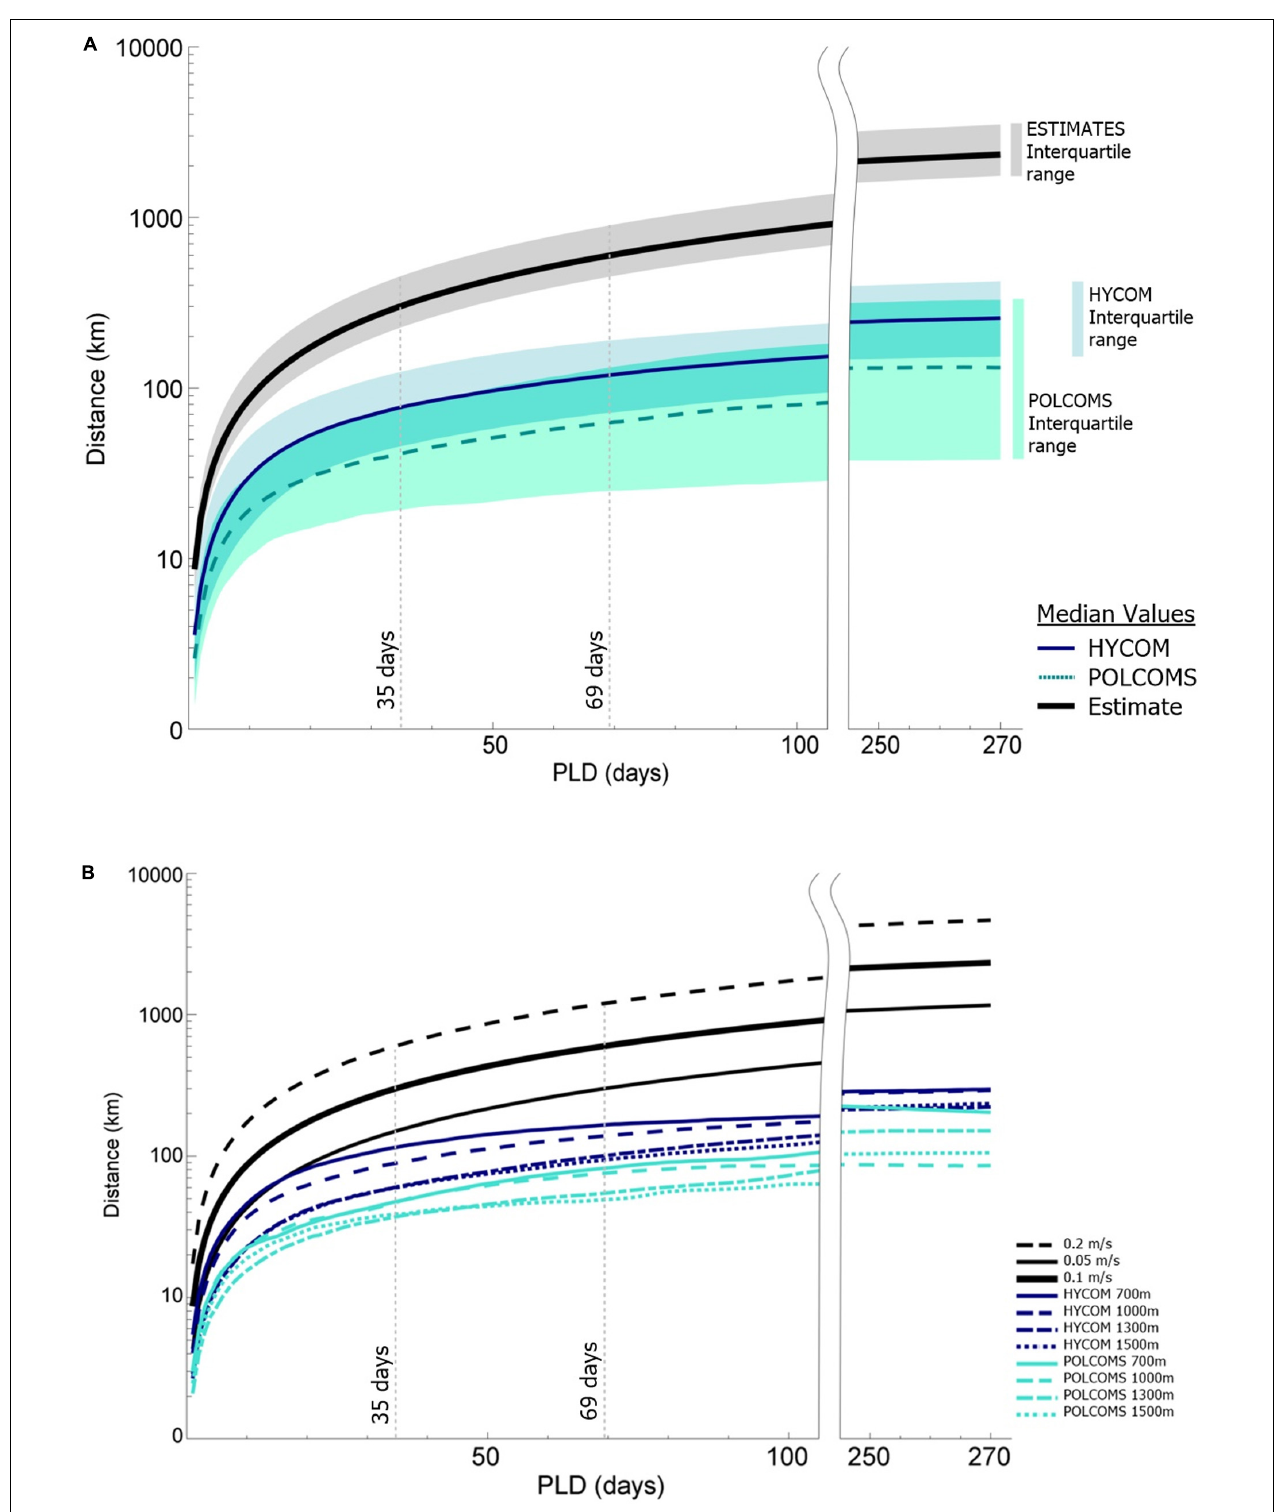
FIGURE 2 | Results plots (after McClain and Hardy, 2010), of median dispersal distance over time for the model predictions as compared to the three estimates. (A) Median values per model (and the 0.1 m/s estimate) with shaded interquartile ranges inclusive of overlap. (B) Median values per depth band per model relative to the three estimates. Reference PLDs are highlighted in line with Hilário et al. (2015) and the PLDs representative of 50% (35 days) and 75% (69 days) of all known deep-sea animals.